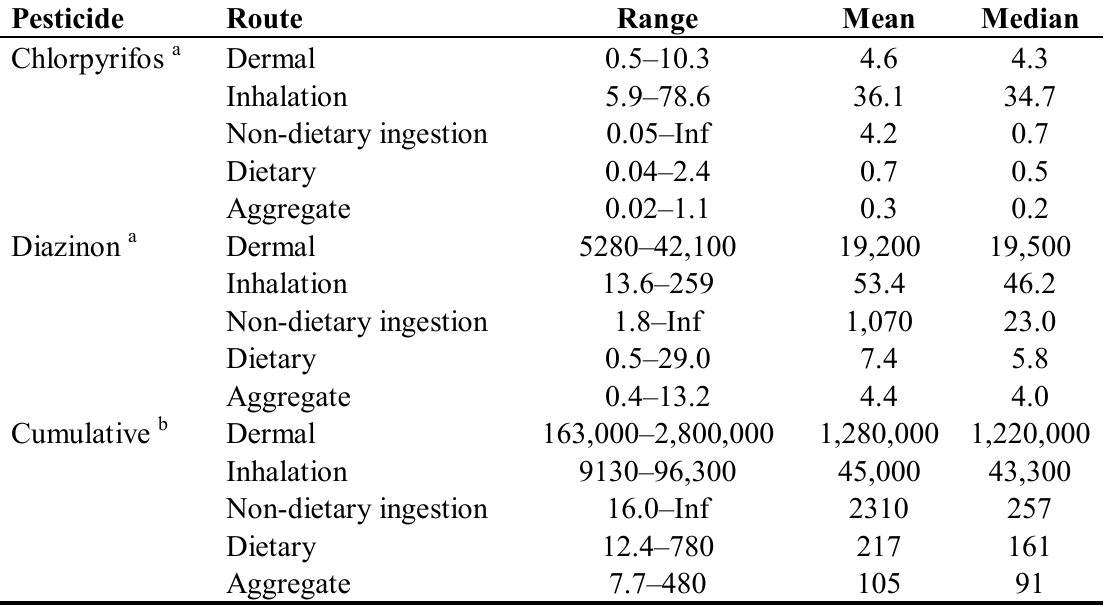
Table 8. Route-specific and aggregate risk indices for farmworker children simulations ( n = 115,000) from chlorpyrifos, diazinon and cumulative exposure. An ARI or RI of less than one suggests a “risk of concern”